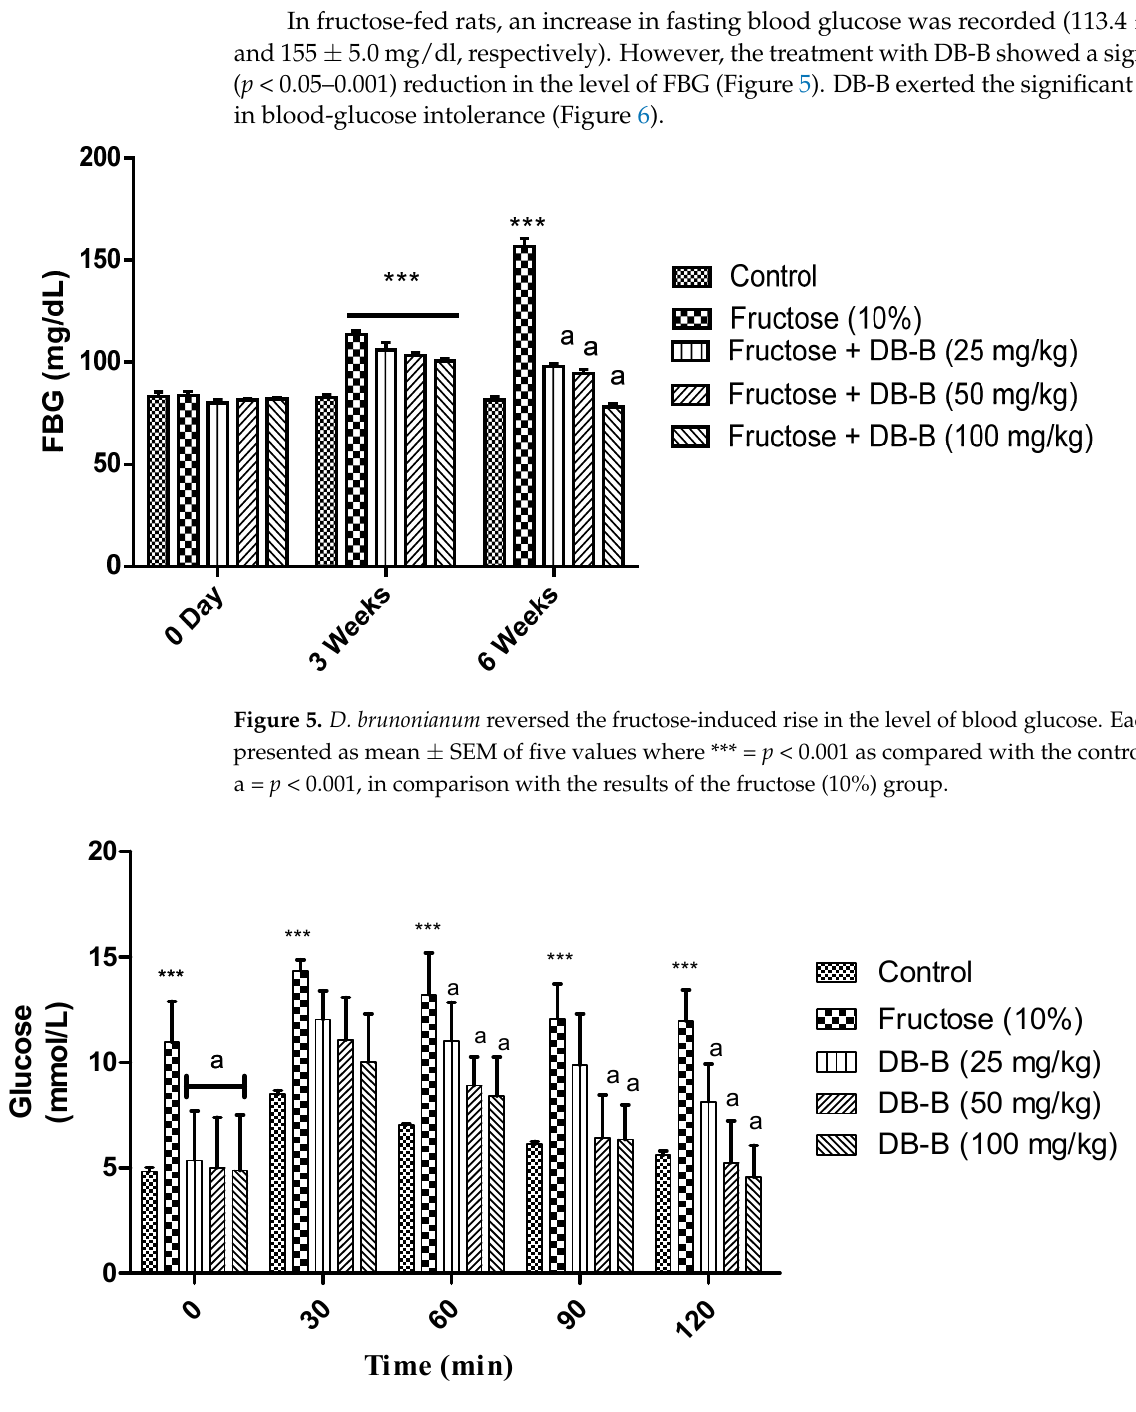
Figure 6. DB-B induced a decrease in glucose intolerance in fructose-fed hypertensive rats. Data was analyzed statistically using two-way ANOVA followed by the Bonferrani test. Results are expressed as mean ± SEM (n = 5) where a = p < 0.001 with respect to fructose (10%), whereas *** = p < 0.001 with respect to the control.